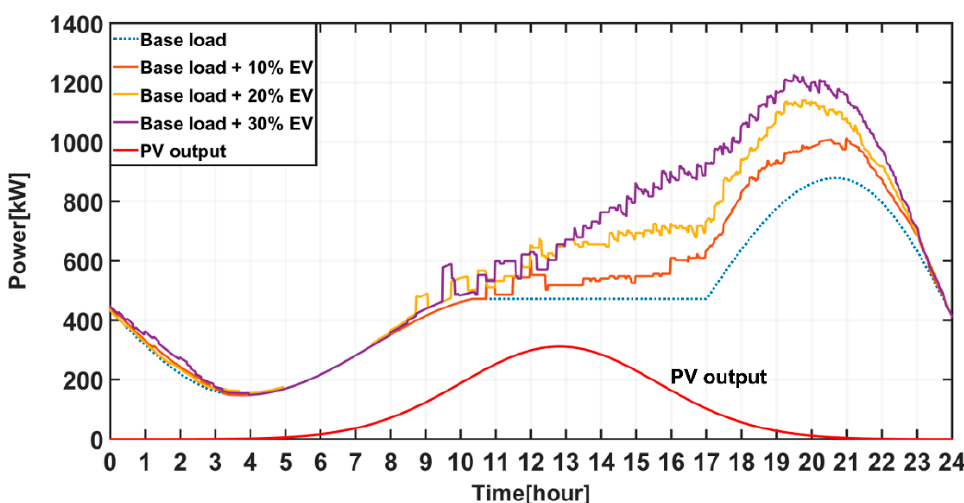
Figure A2. Configuration of apartment complex.